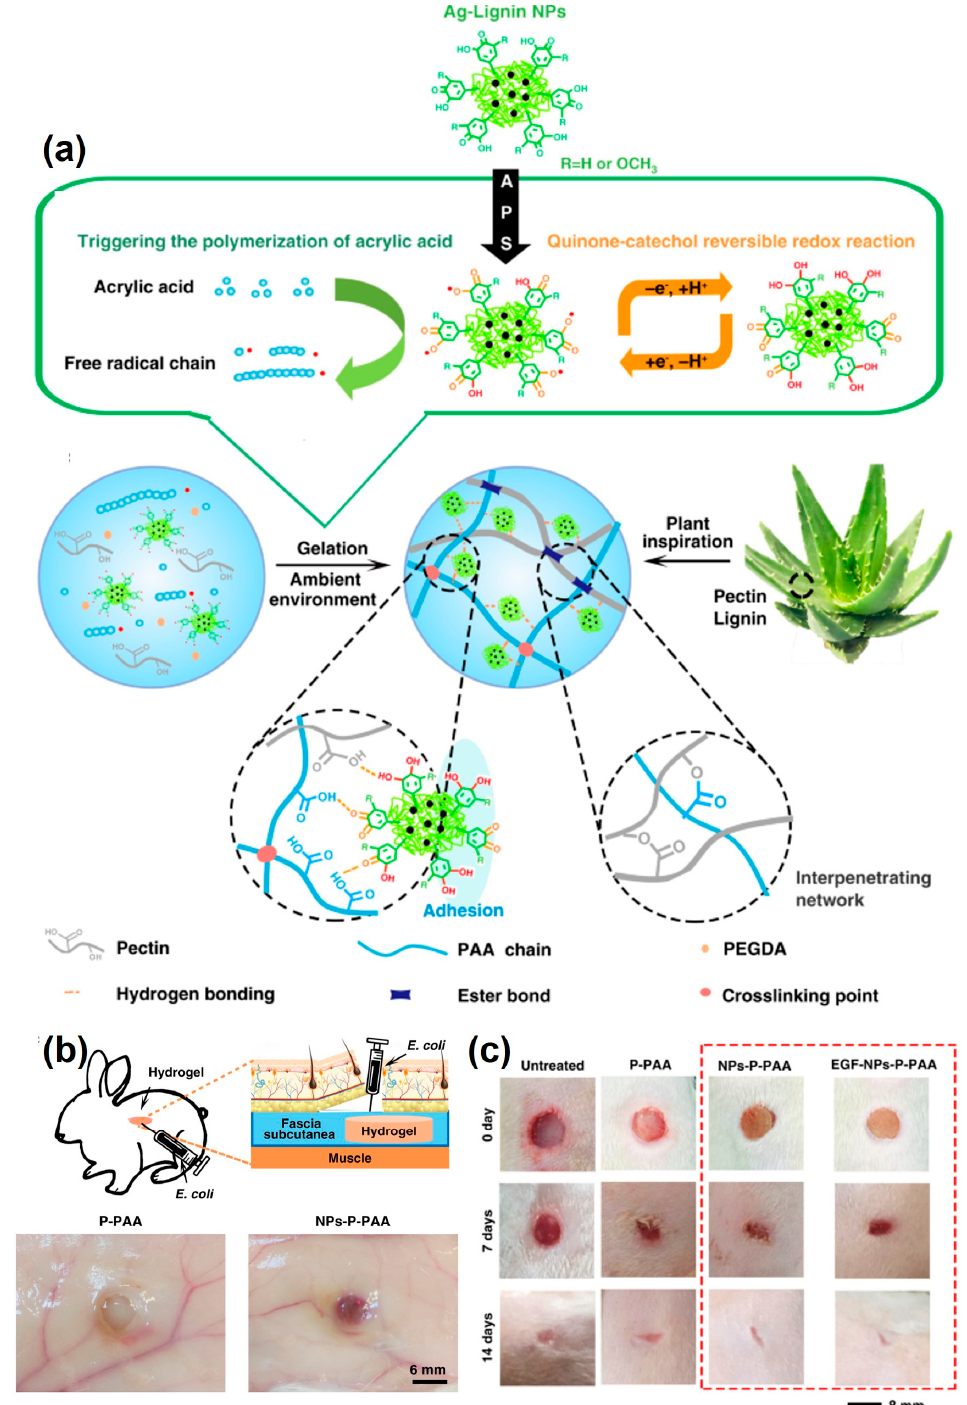
Figure 2. Tough, antibacterial, and adhesive composite hydrogels comprising silver-lignin core-shell nanoparticles (Ag-LNPs), pectin, and acrylic acid (NPs-P-PAA) . ( a ) Schematic illustration of the preparation strategy of the composite hydrogels by the lignin-gelatin solution preparation by Ag-LNPs triggered free-radical polymerization. ( b ) Schematic representation of in vivo antibacterial tests and image of hydrogels 7 days after injection of E. coli suspension, in which Ag-LNPs-penetrated hydrogels are free of infection. ( c ) In vivo wound healing test—representative status of wound defects treated with various hydrogels. EGF represents epidermal growth factor (adapted from ref [74] with permission under CC BY 4.0 license).